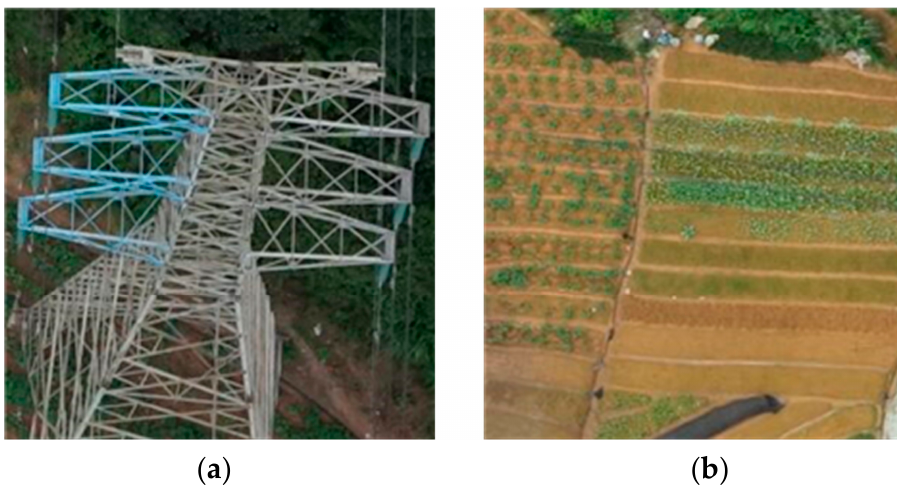
Figure 1. ( a ) The positive sample; ( b ) the negative sample. The positive sample contains critical components of transmission lines, while the negative sample does not.